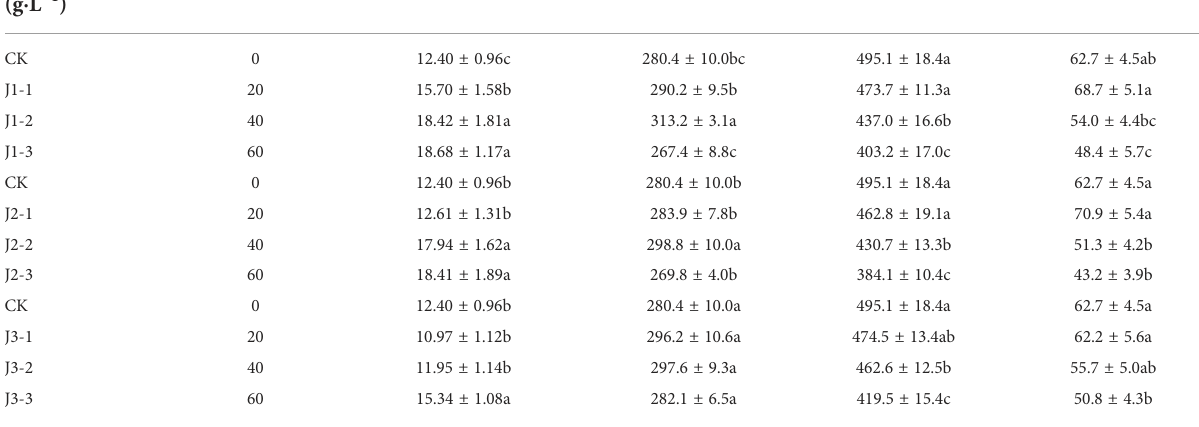
TABLE 3 Responses of antioxidant enzyme activity and membrane lipid peroxidation product content in the leaves of sugarcane seedlings to different root aqueous extracts. Treatment and concentration (g·L − 1